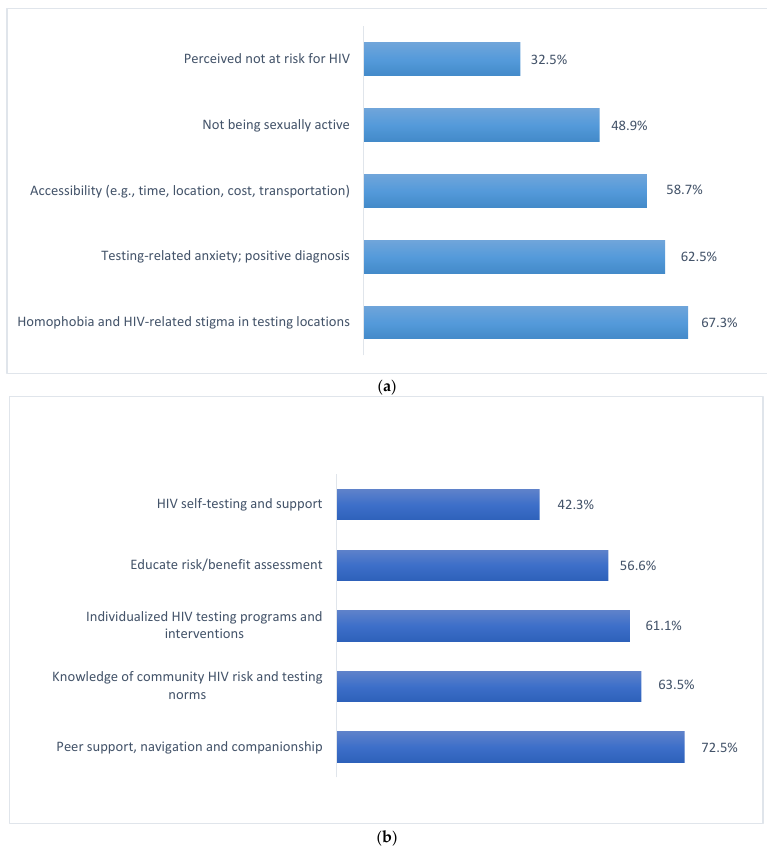
Figure 2. Summary of top identified ( a ) barriers to and ( b ) facilitators of enhancing exposure-influ- enced HIV testing among a sample of PrEP/PEP-naïve YMSM in two US urban areas (N = 261).